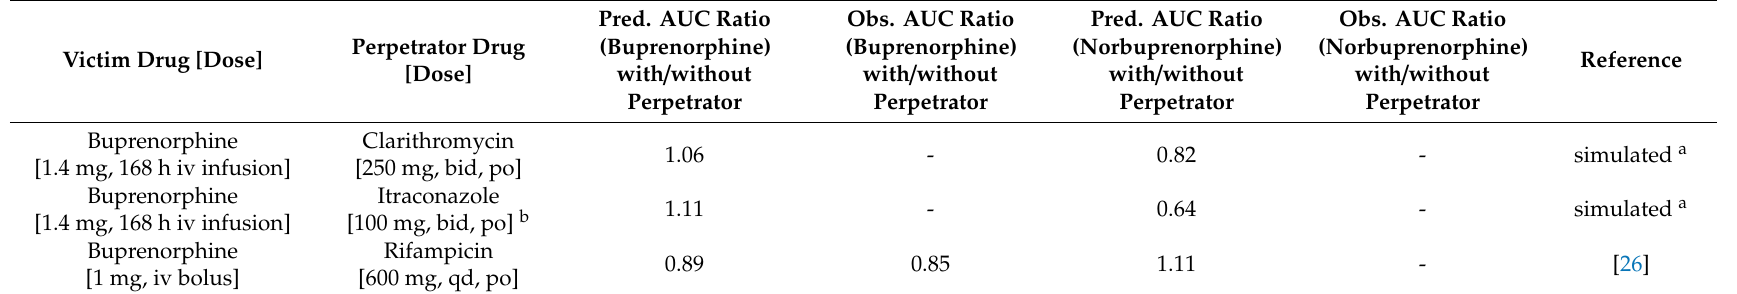
Table 3. DDI study dosing regimens with predicted and observed AUC